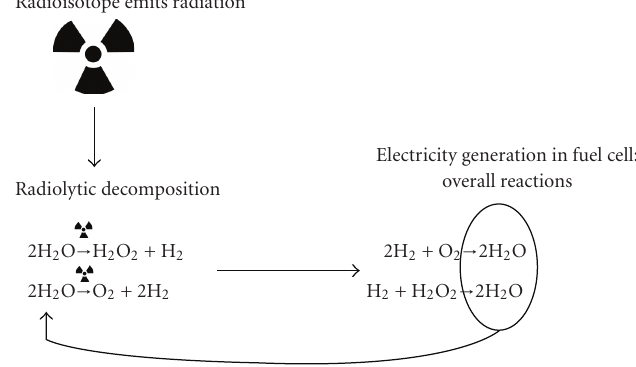
Figure 1: Regenerative cycle for radiolytically powered fuel